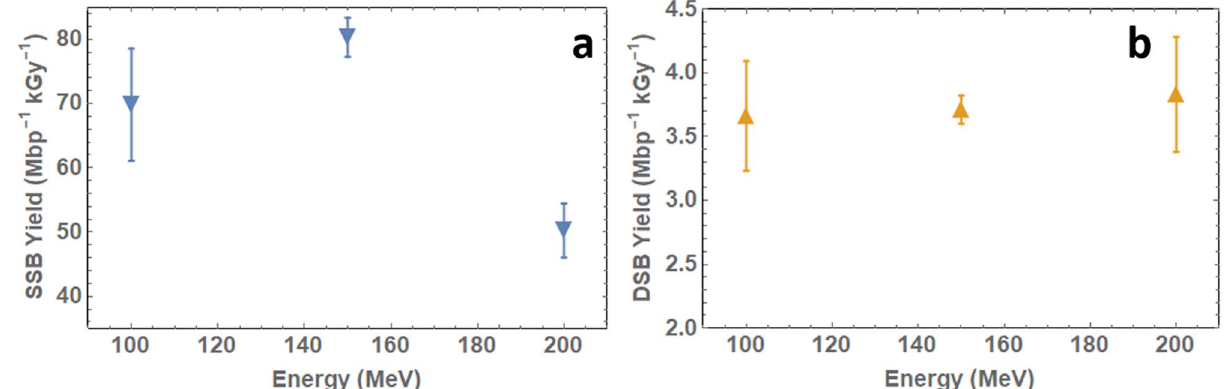
Figure 1. ( a ) Single-strand break yields and ( b ) double-strand break yields for 100–200 MeV electron beam irradiation of dry pBR322 plasmid DNA based on McMahon data fitting 32 .